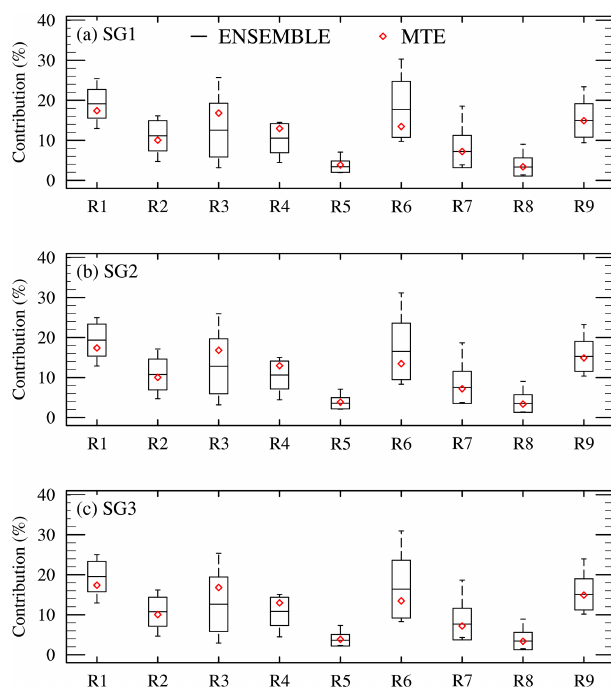
Figure 7. The same as Fig. 5, but for the regional contributions to the seasonality of China’s